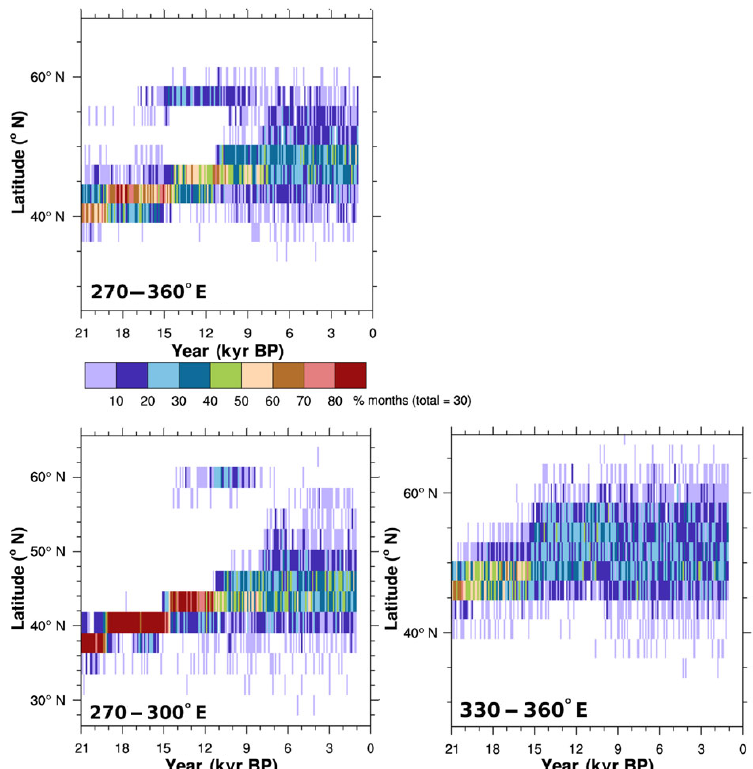
Figure A2. Frequency plots for North Atlantic eddy-driven-jet latitudes as a function of time for the transient deglacial simulation using a revised snow albedo